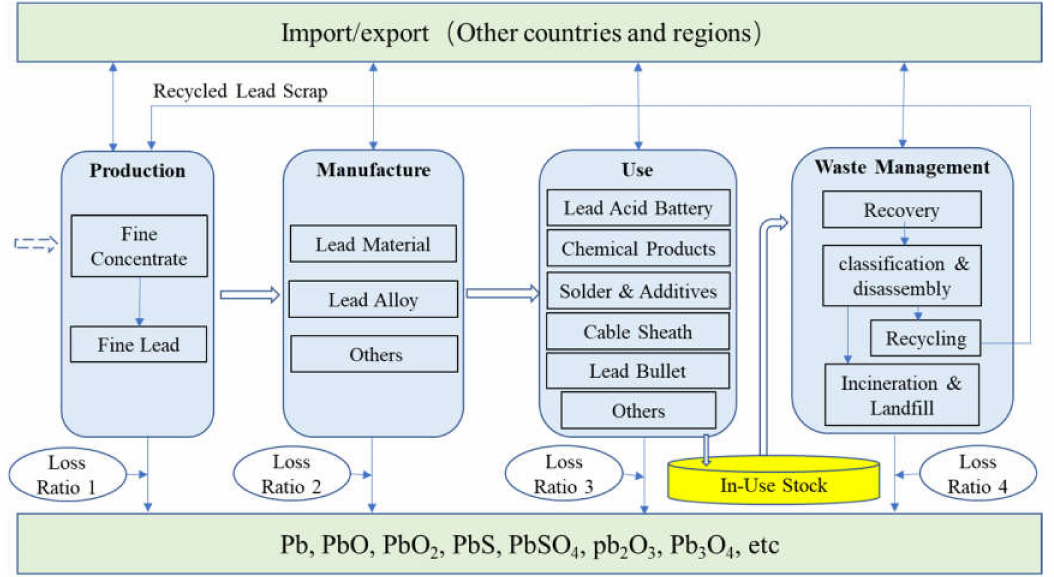
Figure 1. Material flow framework and system boundary of